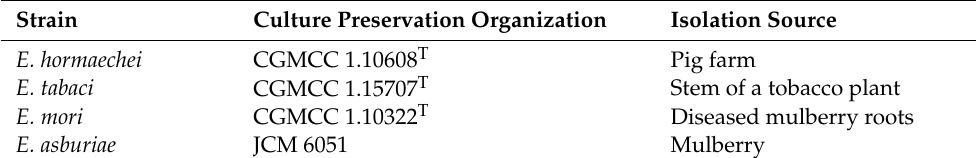
Table 1. Information of Enterobacter strains.